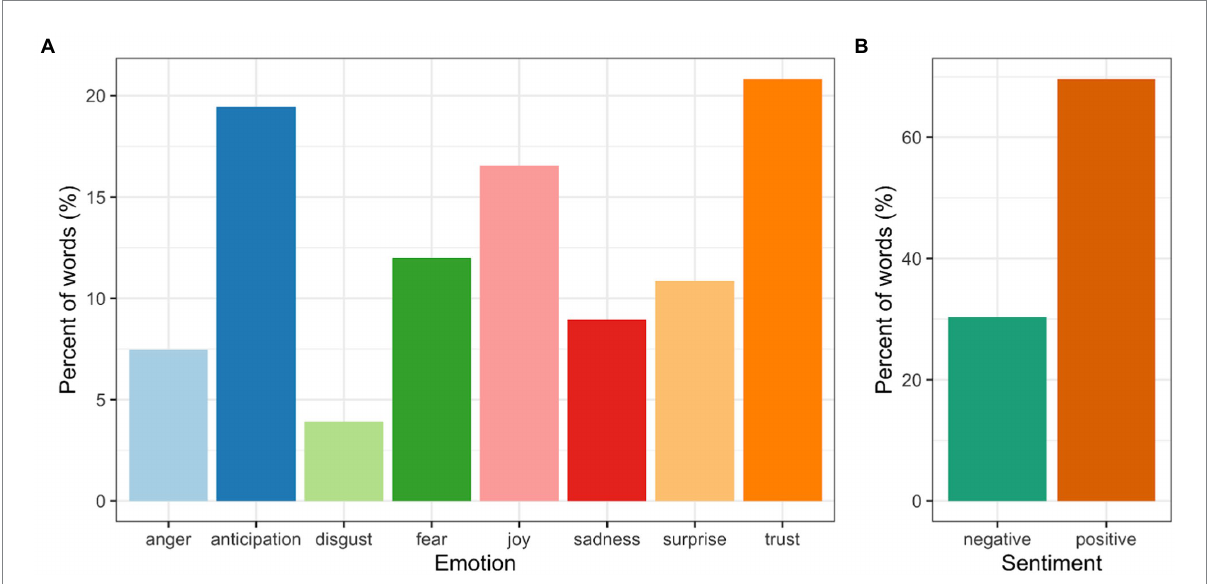
FIGURE 2 Sentiment analysis of workshop transcript. (A) Emotion classification of workshop transcript. (B) Sentiment classification of workshop transcript as percentage of meaningful words from the workshop transcript